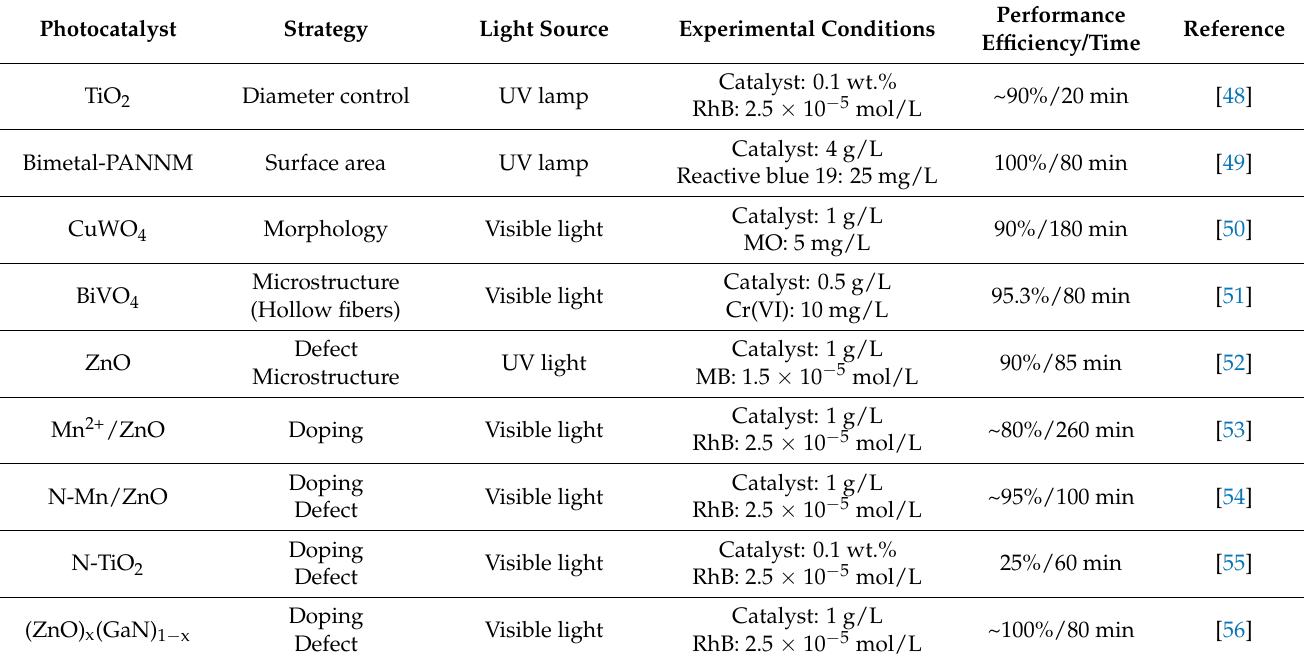
Table 1. Summary of recent advances in ceramic fiber photocatalysts fabricated by